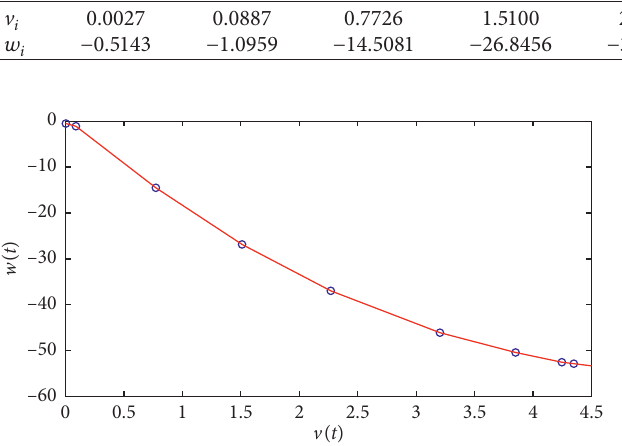
Figure 23: Captured nonlinearity as a piecewise linear function (red) from the estimated breaking points (blue